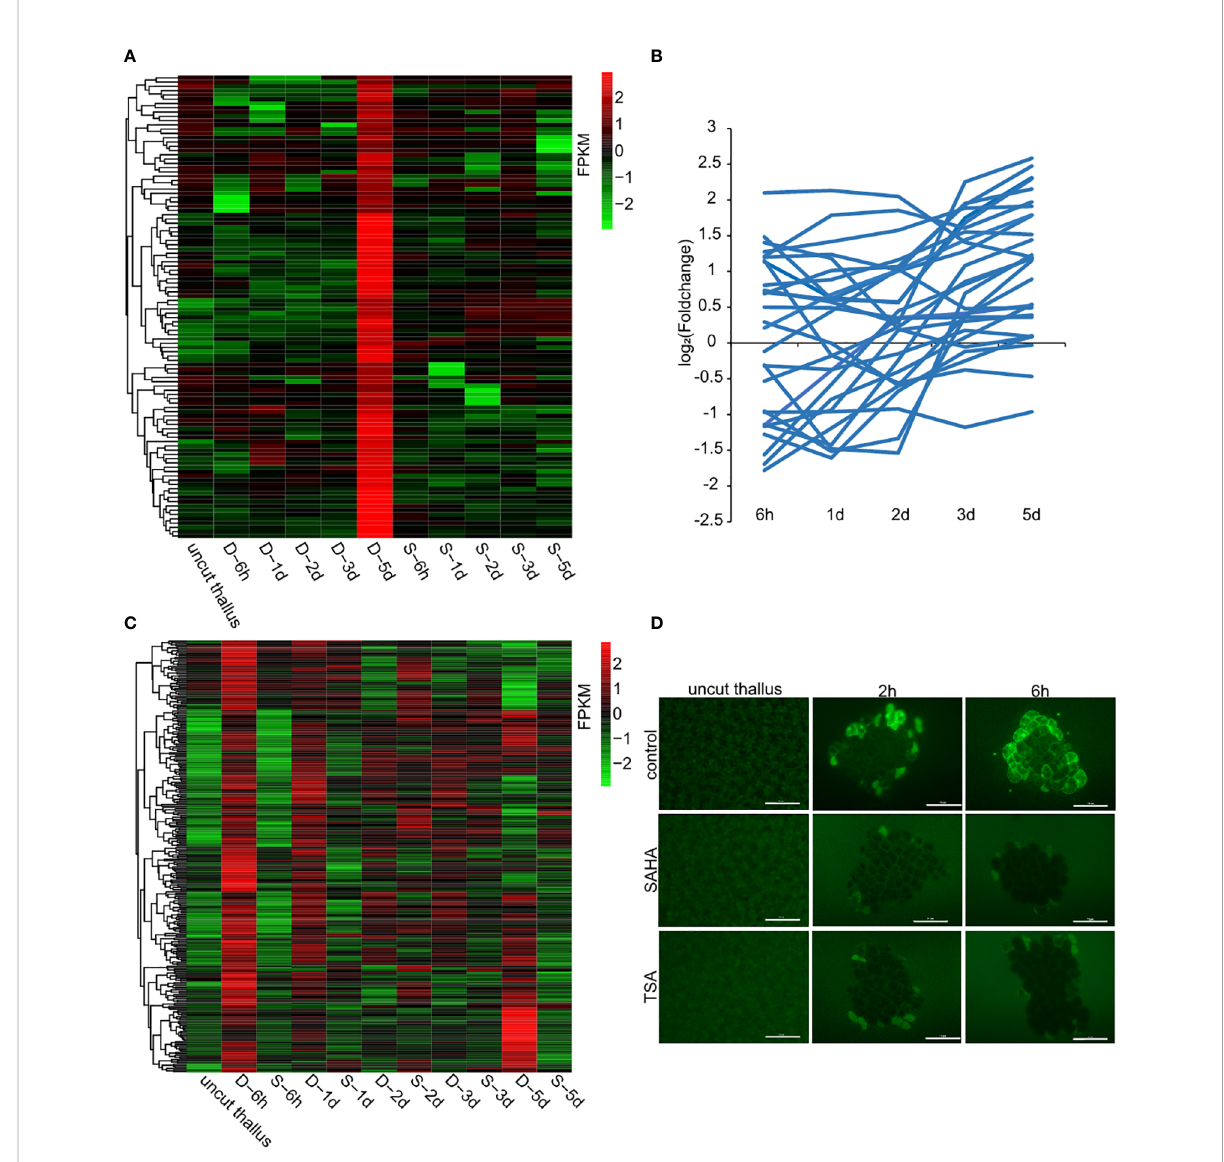
FIGURE 4 Candidate genes that were transcriptionally regulated by HDACs. (A) Transcriptional levels of sporangia-speci fi c genes at different time points in control media (marked as D-) and SAHA-supplemented media (marked as S-). The control sample stands for uncut thalli. The log 2 value of FPKM foldchange compared to the control sample at each time point for individual genes are displayed, as indicated by the color bar. (B) Transcriptional foldchanges of genes related to DNA replication in SAHA-supplemented media. (C) Heatmap showing transcriptional levels of the 291 candidate genes in control media and SAHA-supplemented media. The D- and S- samples at the same time point placed adjacently to underline the contrast between them; (D) ROS signals in control media, SAHA-supplemented media and TSA-supplemented media after wounding (Bars = 50 m